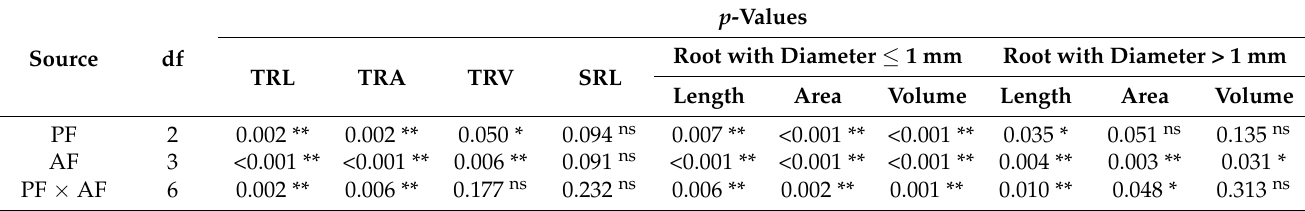
Table 4. Statistics (df, degrees of freedom; p -values; and significance levels) of two-way ANOVAs testing the main and interaction effects of pre-hardening fertilization type and autumn fertilization level on root morphology of Pinus koraiensis seedlings.